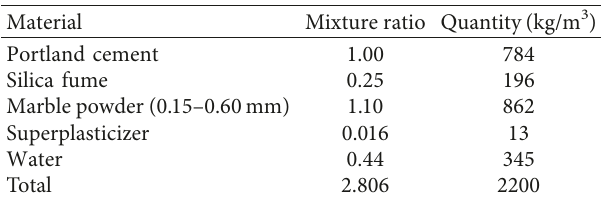
Table 13: The mixture and amounts for the production of MSWC and MSCC.